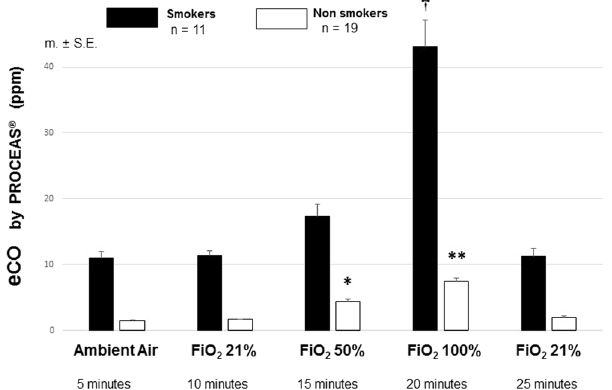
Figure 3. eCO measured by ProCeas in smokers (n = 11) and non-smoker (n = 19) subjects Values are given from the five minute duration of the steady-state after FiO 2 changes. † p < 0.001 eCO with FiO 2 100% versus every other situations in smokers. ** p < 0.001 eCO with FiO 2 100% versus every other situations in non-smoker